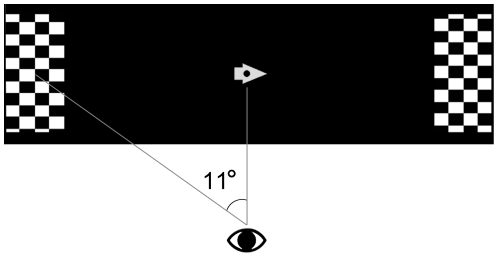
The visual stimuli.